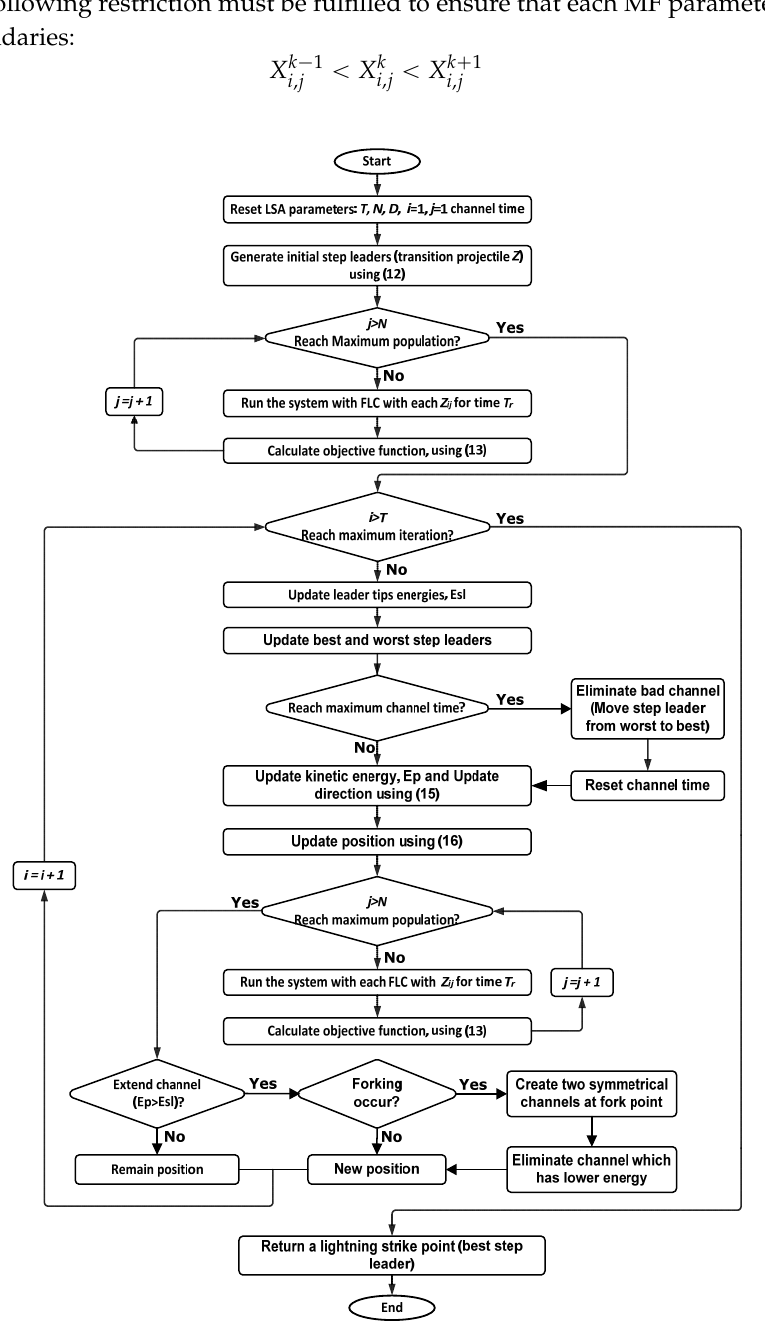
Figure 5. Proposed LSA ‐ based optimum FLC design procedure.